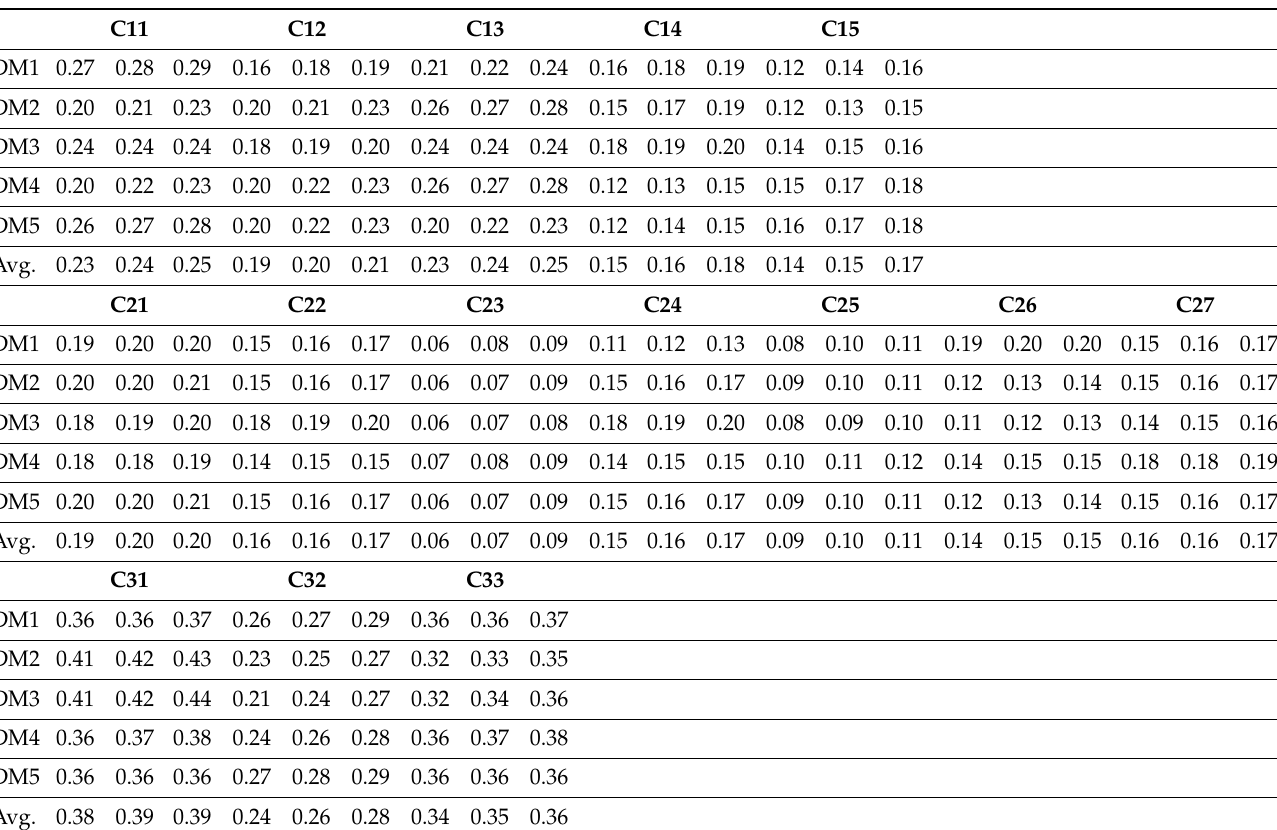
Table 6. Weights of